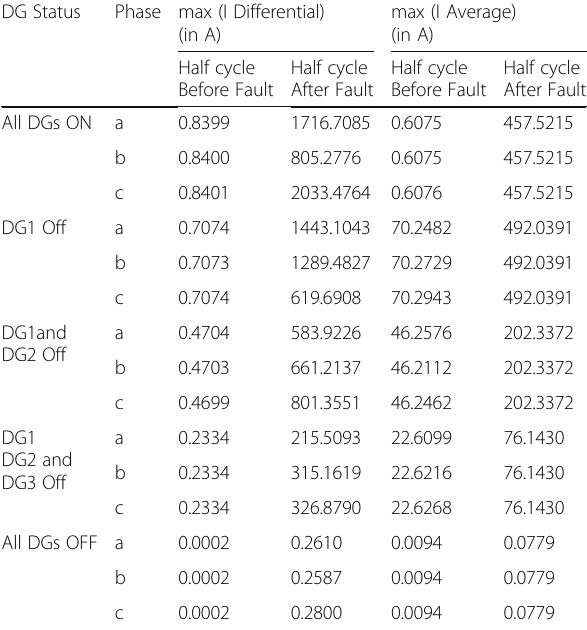
Table 4 Effect of variation of penetration level of the DG ’ s on the magnitude of fault current (differential and average) at distribution Line DL AB for a triple line to ground fault (abc-g) fault, with fault distance ratio (FDR) = 0.6 and fault resistance (R f ) = 20 Ω , respectively, where the microgrid is operated in islanded mode